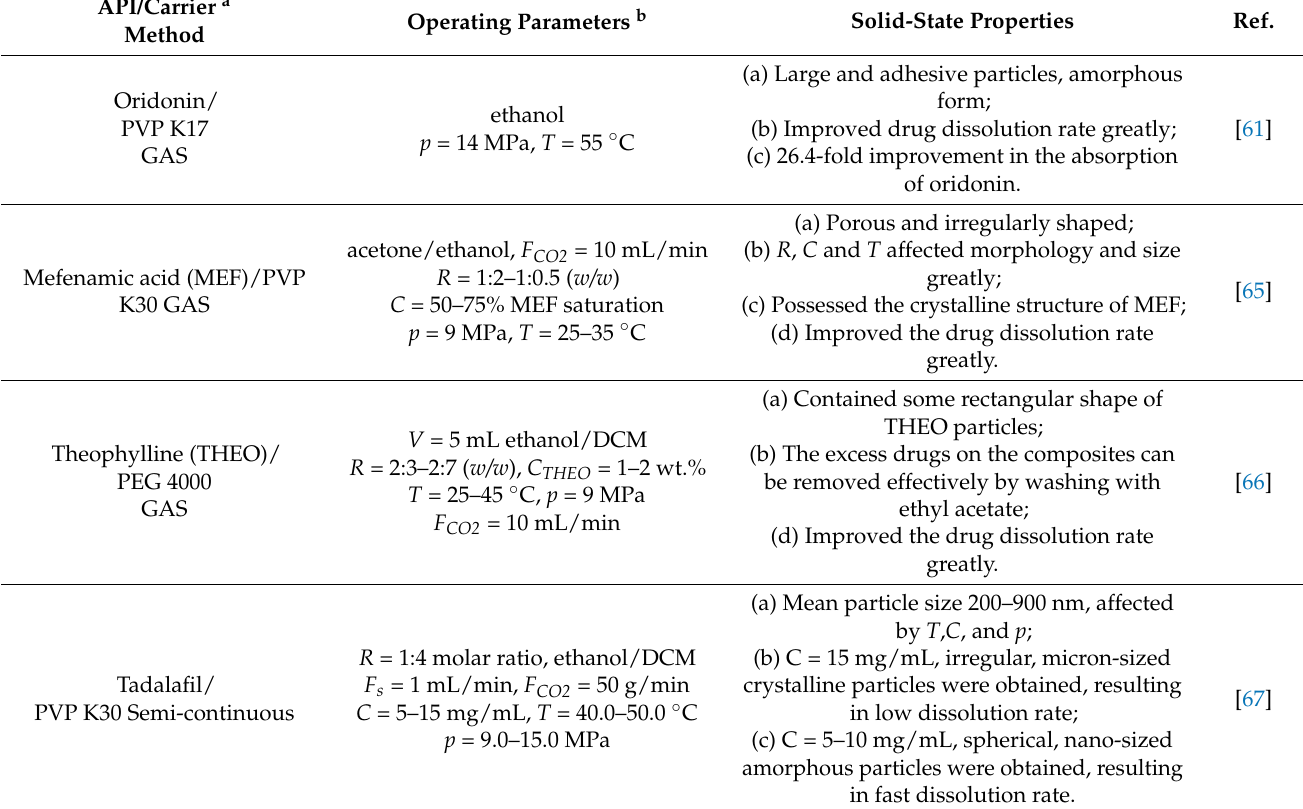
Table 2. Examples of solid dispersions prepared via the SAS